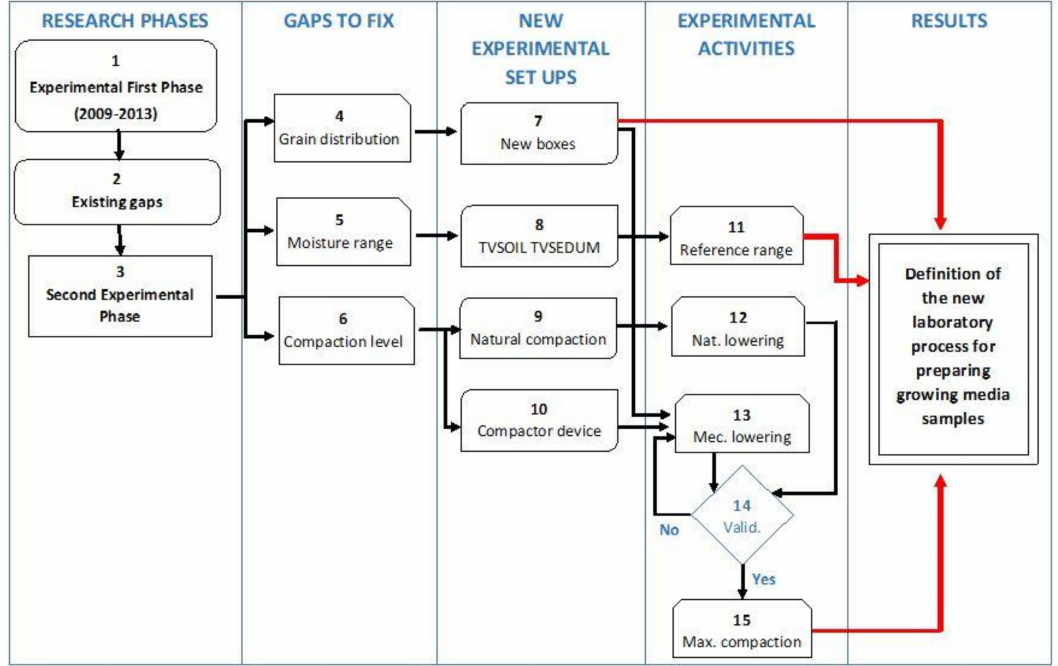
Figure 1. Flowchart of the proposed methodological